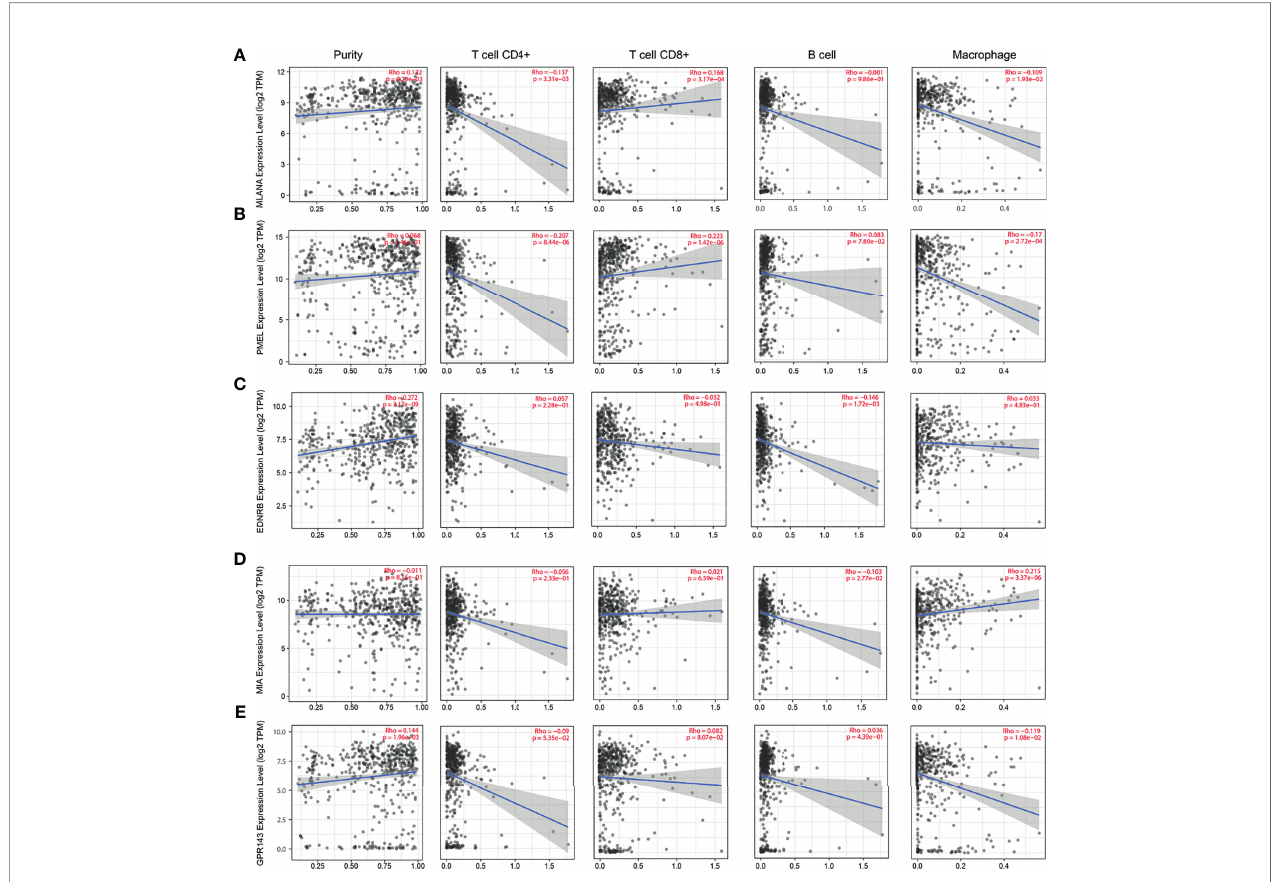
FIGURE 6 | Correlation between candidate genes and immune cell in fi ltration of MLANA , PMEL , EDNRB , MIA , and GPR143 . (A) Correlation between the expression of candidate genes (A) MLANA , (B) . PMEL , (C) EDNRB , (D) MIA , and (E) GPR143 and the levels of immune cell in fi ltration (tumor purity, CD4+ T cells, CD8+ T cells, B cells, and macrophages from left to right,